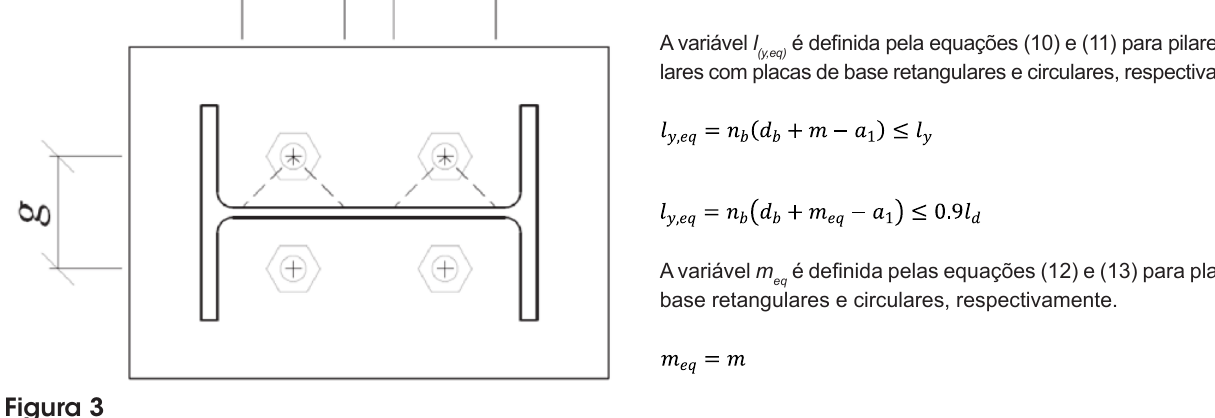
Largura efetiva de flexão para chumbadores entre as mesas do pilar